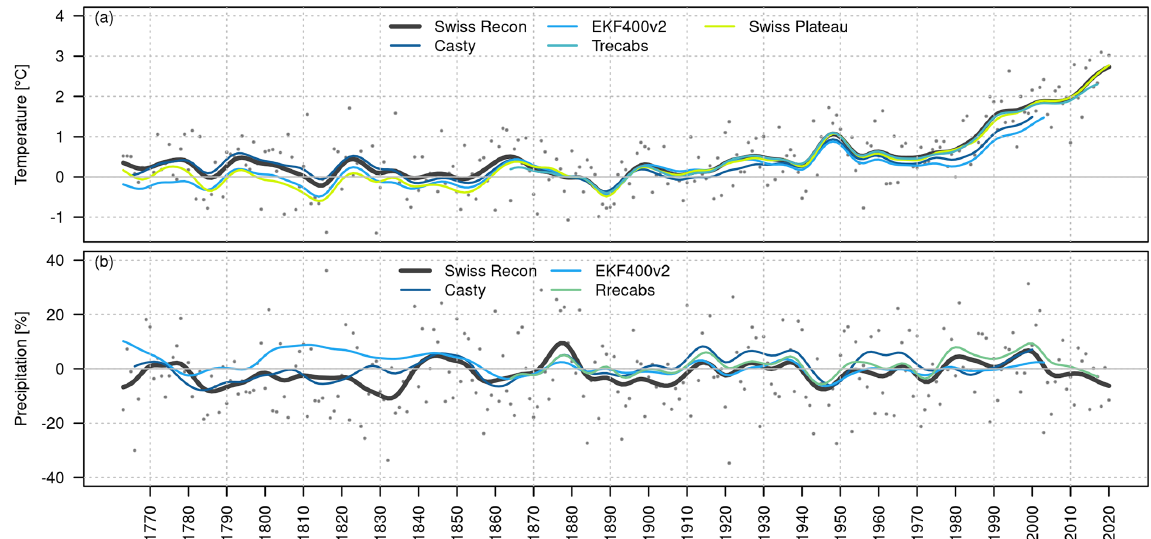
Figure 8. (a) Long-term evolution of annual temperature anomalies in different data sets. (b) Long-term evolution of annual precipitation anomalies as a percentage deviation from the mean. The time series are smoothed with a Gaussian filter ( σ = 3 years). Grey dots show reconstructed annual anomalies. All anomalies are calculated with respect to the 1871–1900 climatology for each data set. The time series either represent the field means (TrecabsM1864/RrecabsM1864, Swiss reconstruction) or the closest grid point of the data set. The Swiss Plateau time series is based on the Bern and Zurich series as described in Brugnara et al. (2022).